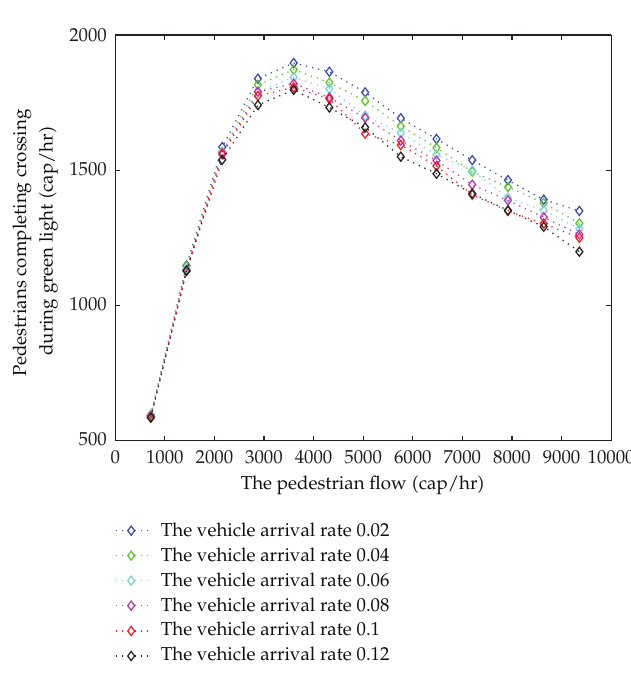
Figure 3: The relationship between pedestrians completing crossing and pedestrian tra ffi c demand (cid:6) 25s green light time and 5m crosswalk width (cid:7) .